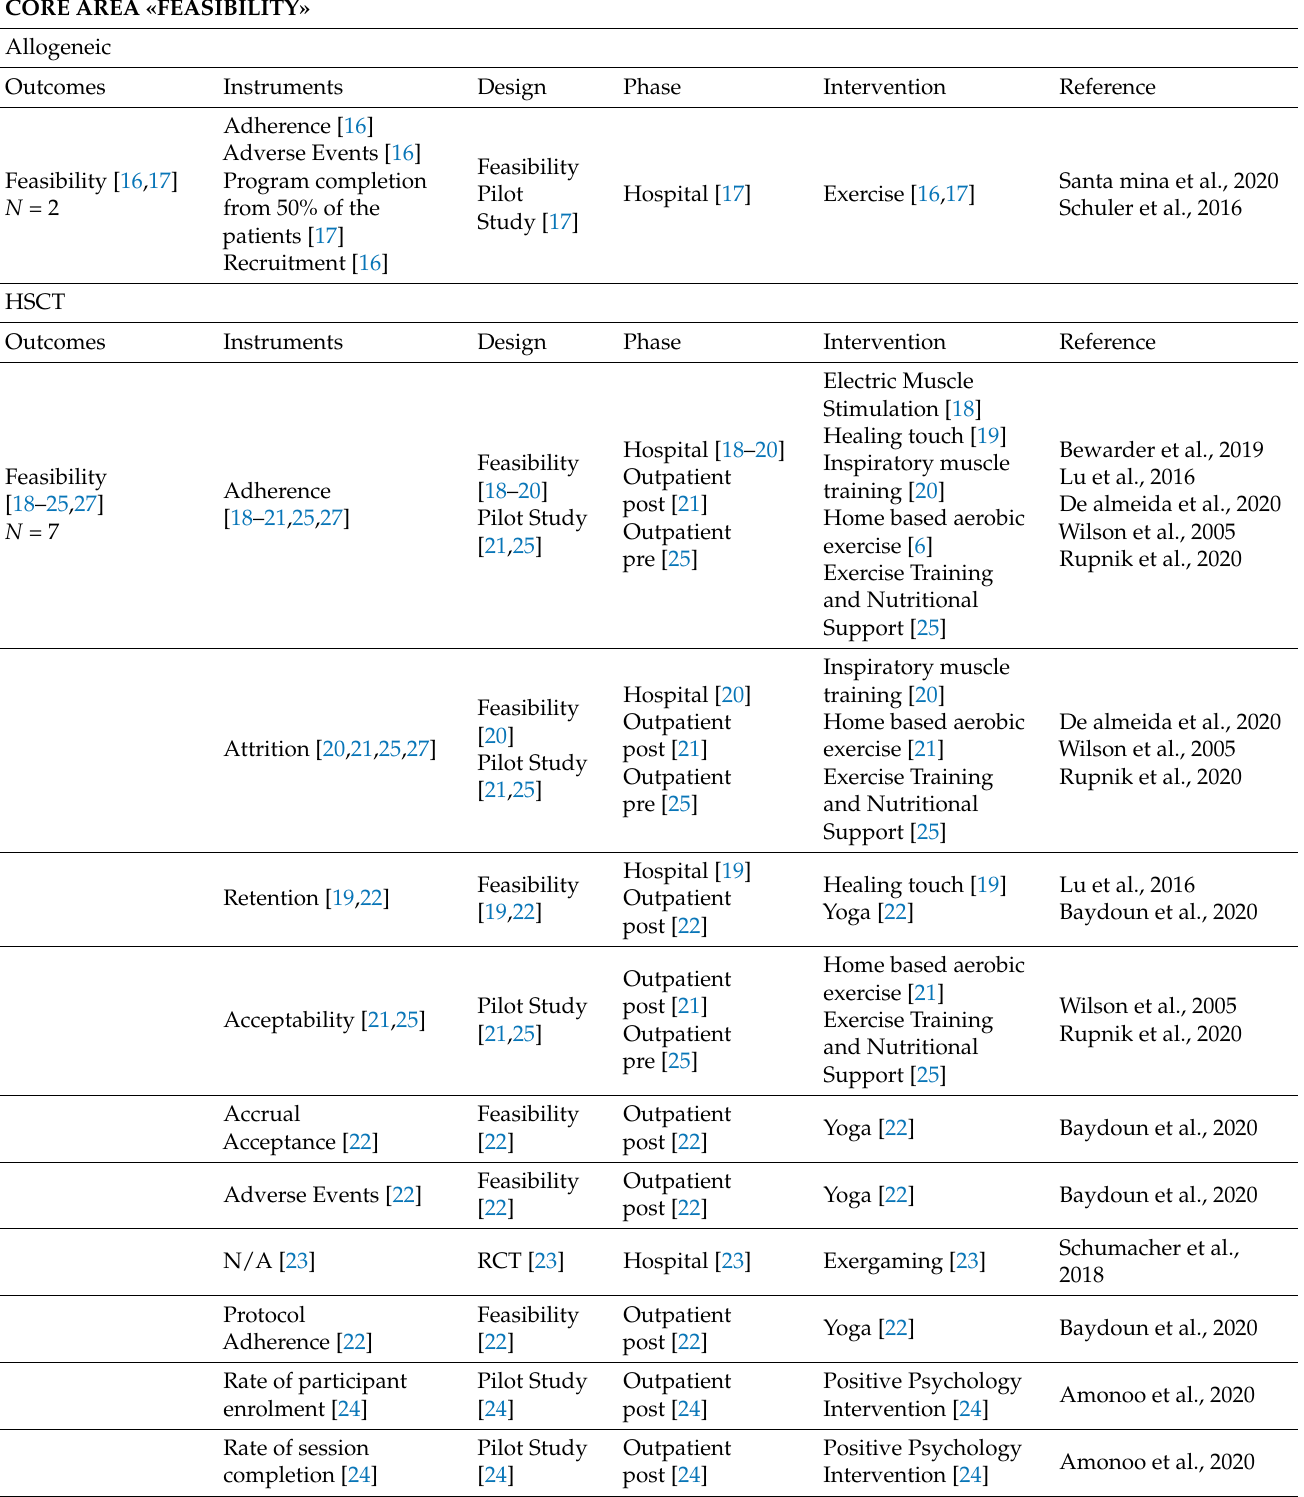
Table 2. Outcomes and outcome measurement